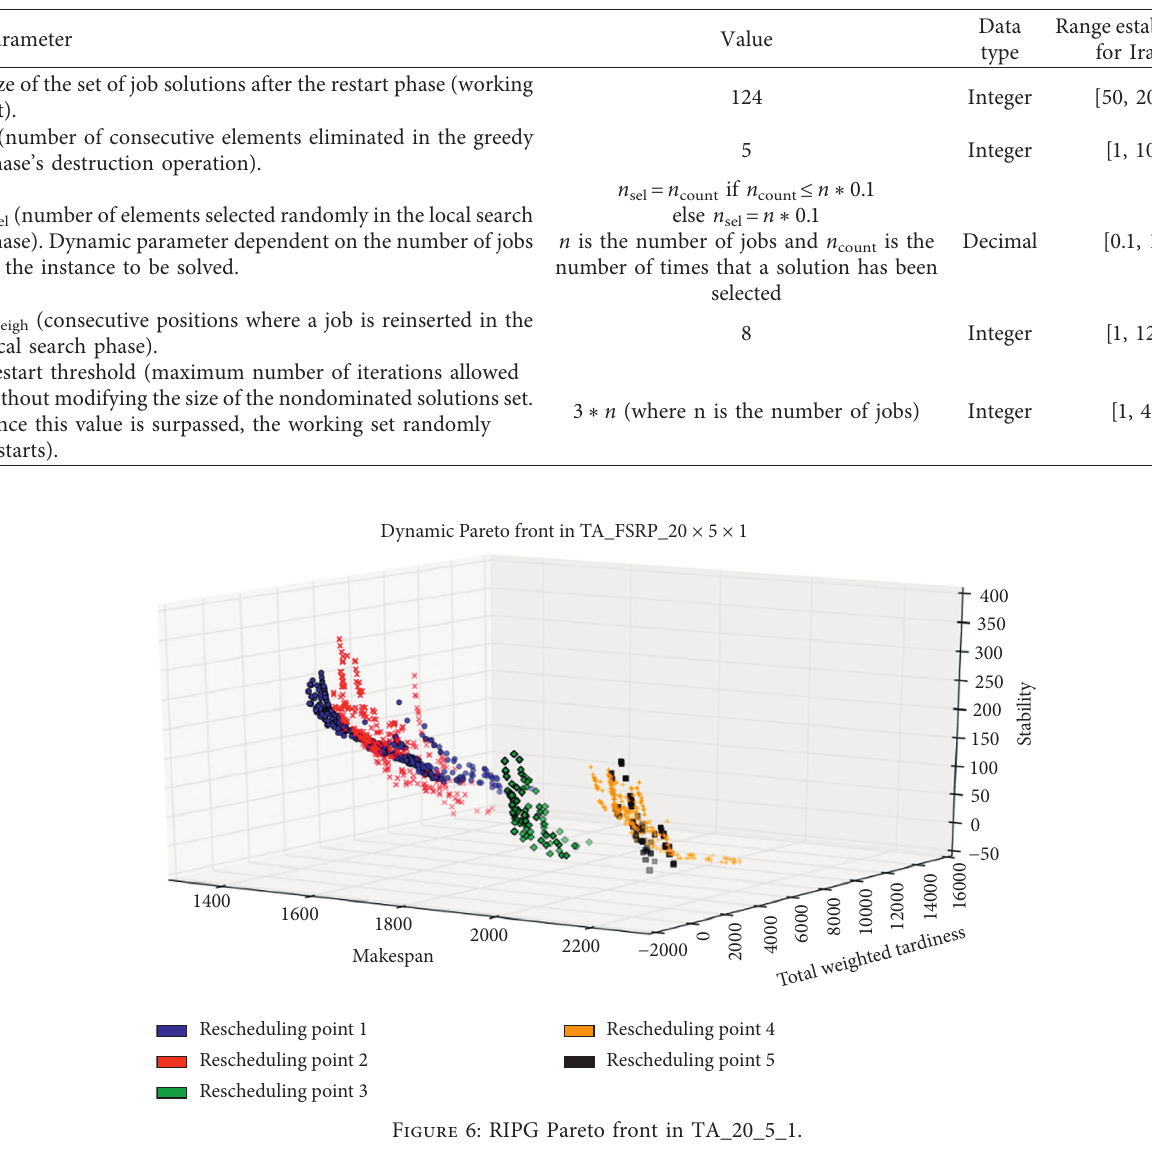
Table 2: Automatic RIPG configuration via Irace.